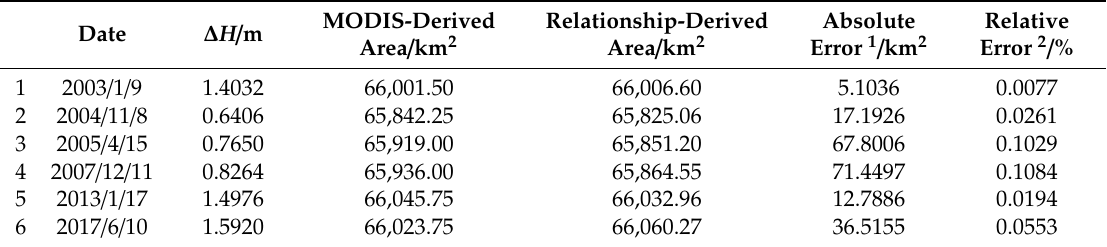
Table 4. Comparison of lake surface area derived from MODIS images and relationship